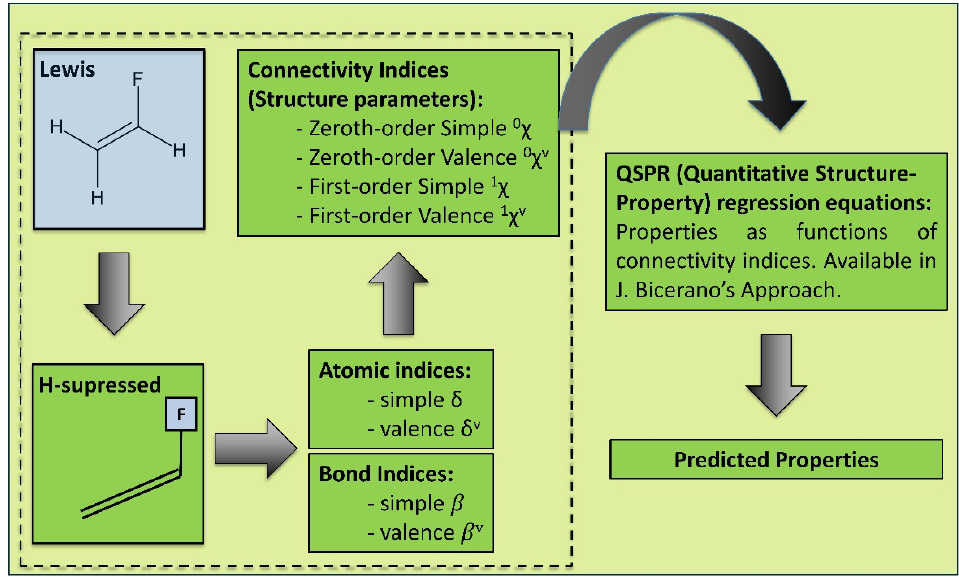
Figure 3. Quantitative Structure-Property Relationship (QSPR) approach; topological method and connectivity indices [38], reproduced from [4].